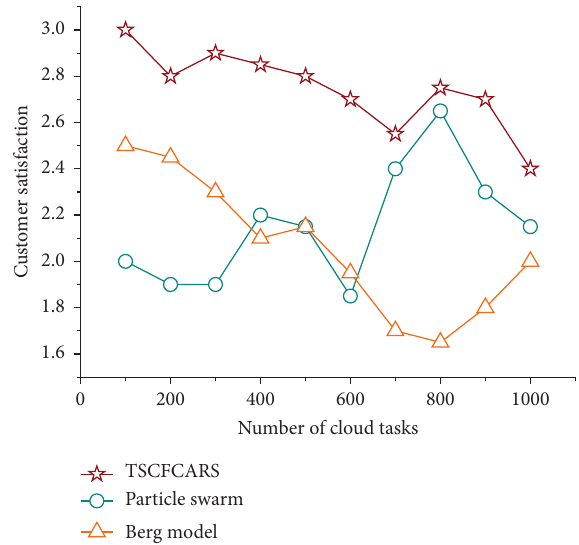
Figure 8: Comparison of user satisfaction with cloud service tasks.